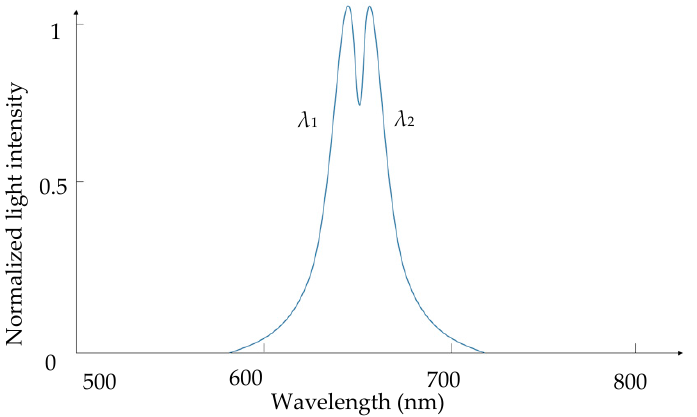
Figure 2. Overlap of the signals from the top and bottom surfaces of transparent specimen ( λ 1 and λ 2 represent two different wavelengths, respectively).